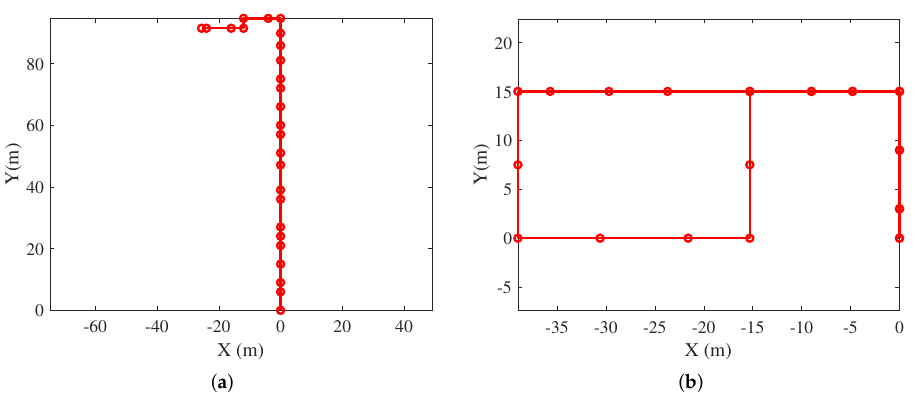
Figure 6. The real trajectories in the office building A and B. ( a ) The office building A; ( b ) The office building B.